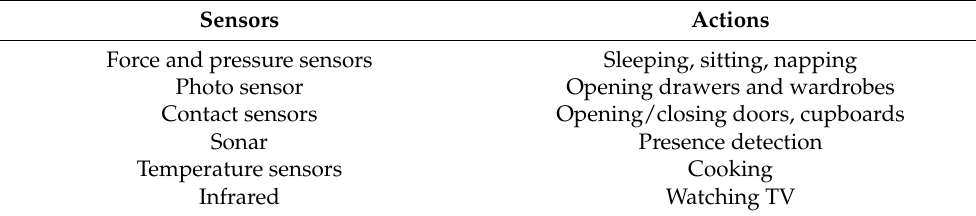
Table 1. Sensors and their associated actions.